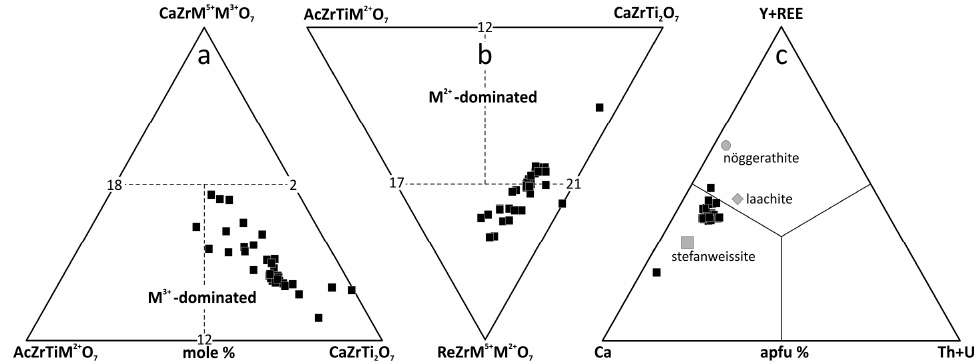
Figure 11. Classification diagrams for M 3+ -dominated ( a ) and M 2+ -dominated zirconolites ( b ) based on endmember proportions (mol.%) calculated from crystal formulae based on four cations and a cationic charge equal to 14, with projection points of zirconolites from Hajná č ka (black squares). Numbers on tie-lines refer to the substitutions documented in Figure 10. Boundaries are constructed using the dominant valency rule [32]. ( c ) Classification diagram based on atomic proportions of eightfold-coordinated cations, with projection points of zirconolites from Hajná č ka (black squares), steffanweissite, laachite, and nöggerathite holotypes from the Tertiary Laacher See volcano of the Eifel region, Germany [33–35]. Boundaries are constructed using the dominant component rule [32].